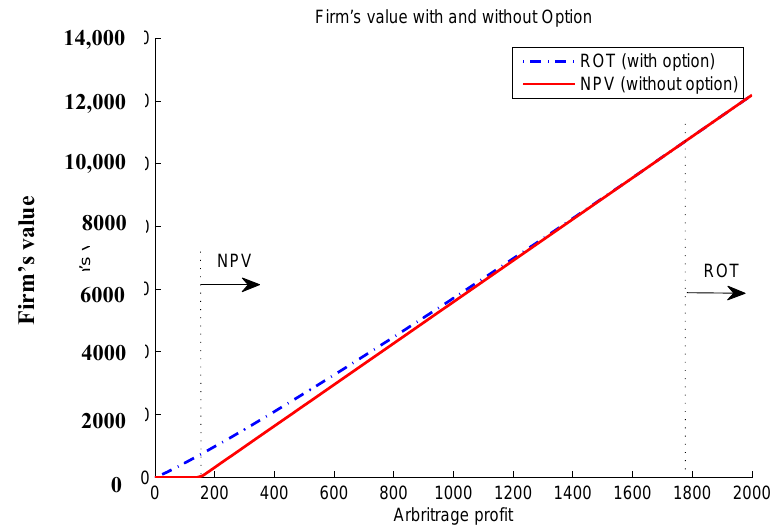
Figure 6. Comparison of ROT and NPV for large volatility.